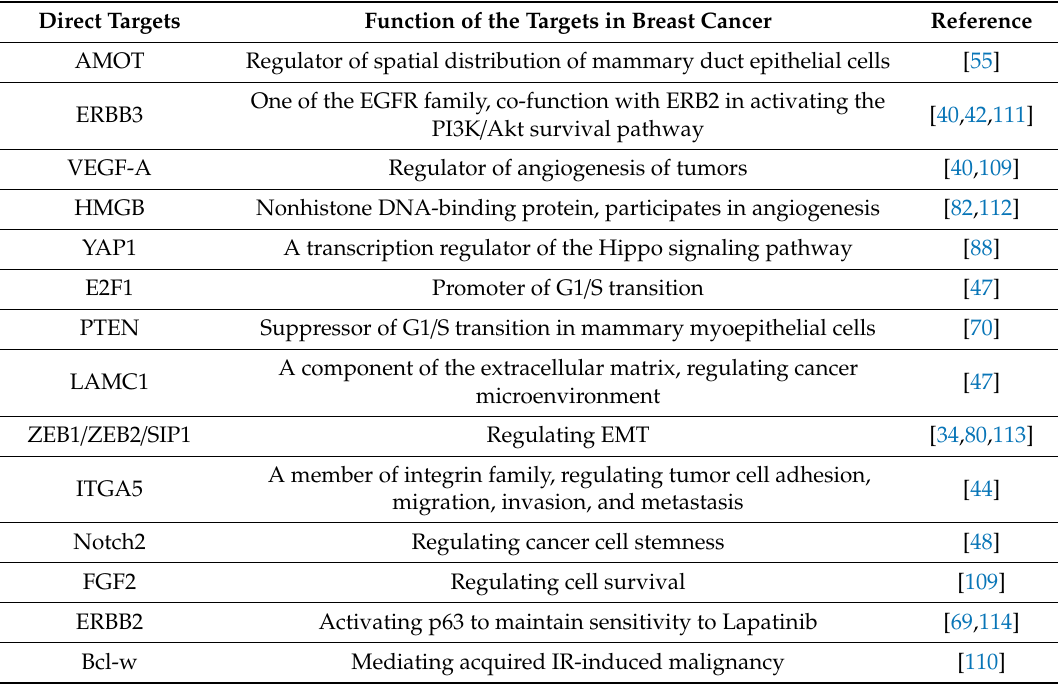
Table 1. A summary of the validated direct targets of miR-205-5p in breast